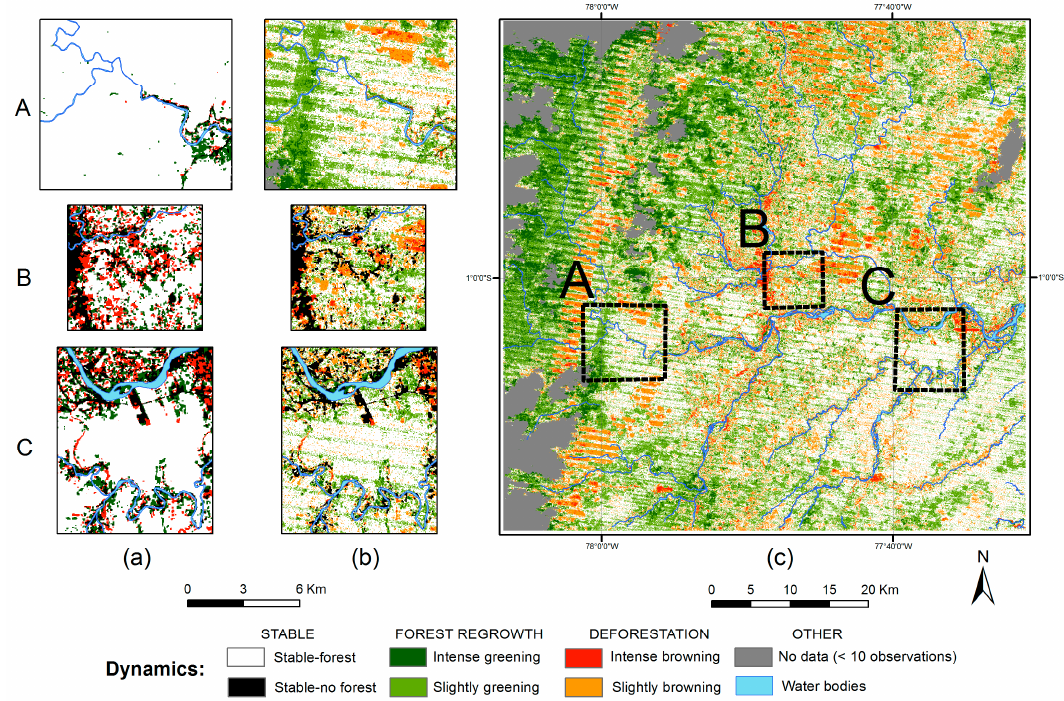
Figure 13. Application of the ECP-optimized processing chain. Study areas are shown in rows (A, B, C) and columns refer to ( a ) LCCM, ( b ) The forest dynamics map obtained, and ( c ) Its application to a larger area.